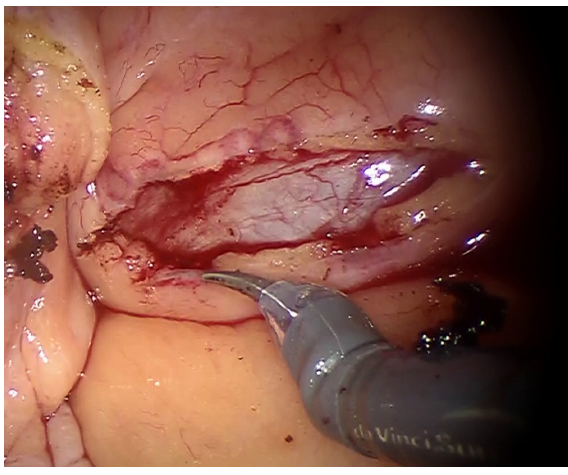
Figure 4. Local fat extirpation at the site of implantation over the bladder